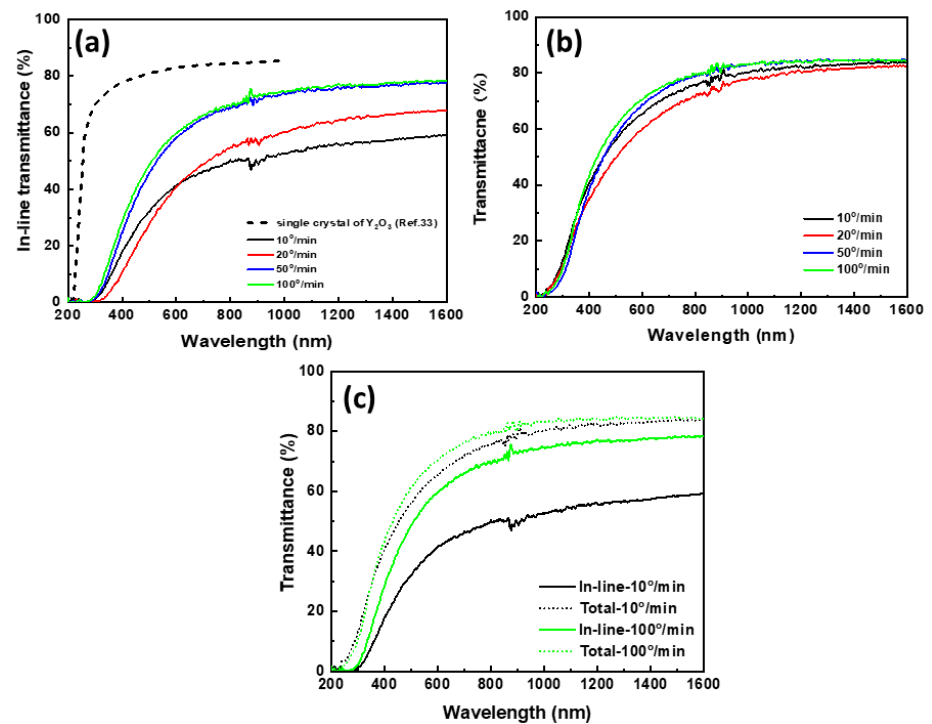
Figure 8. Typical optical properties of the Y 2 O 3 with the various heating rates; ( a ) in-line and ( b ) total-forward transmittance spectra, T in and T total , at the wavelength range of λ = 0.2–1.6 µ m, and ( c ) the comparation of T in and T total for the samples sintered at 10 and 100 °C/min.